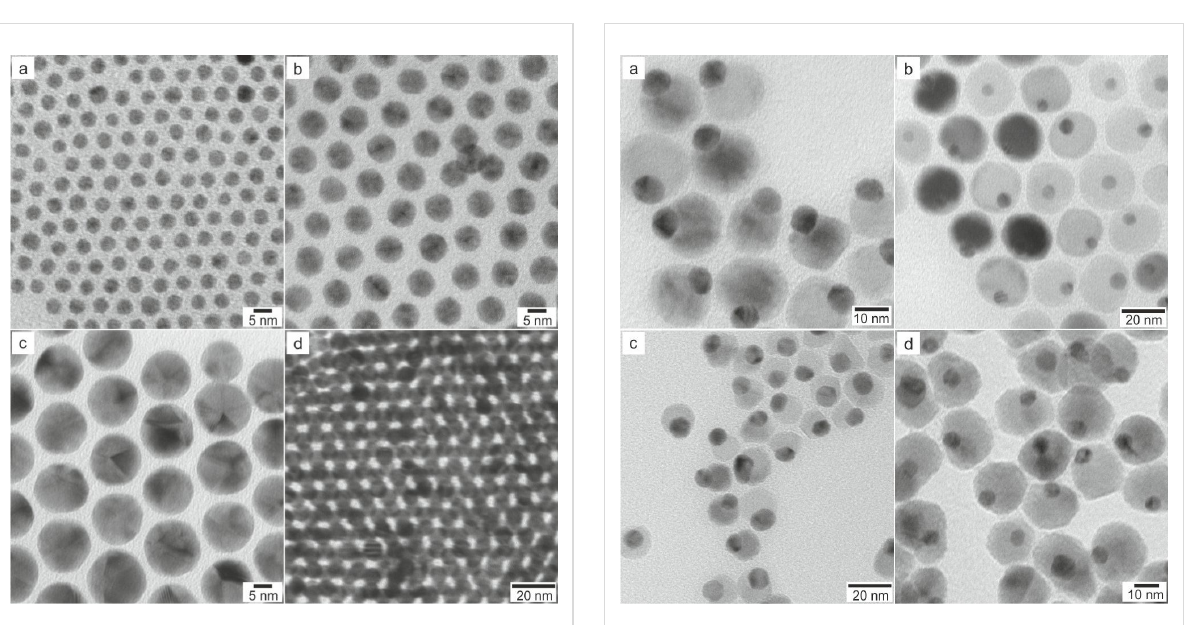
Figure 8: TEM bright field images of Au nanoparticles with different diameters (a) 4 nm, (b) 8 nm, and (c) 15 nm; (d) 2D superlattice of 8 nm Au nanoparticles.